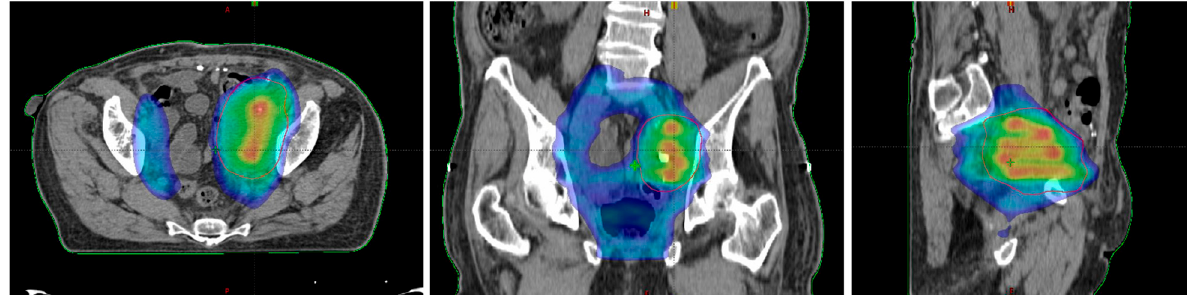
Figure 2. Three-Dimensional (3D) rendering of bulky metastatic iliac lymph node packets from urothelial bladder cancer in a patient candidate for a salvage pelvic radiotherapy (on the left ). On the right , 3D dose distribution with a lattice simulation approach. Blue is for the conventional standard dose, red for high peak ones.